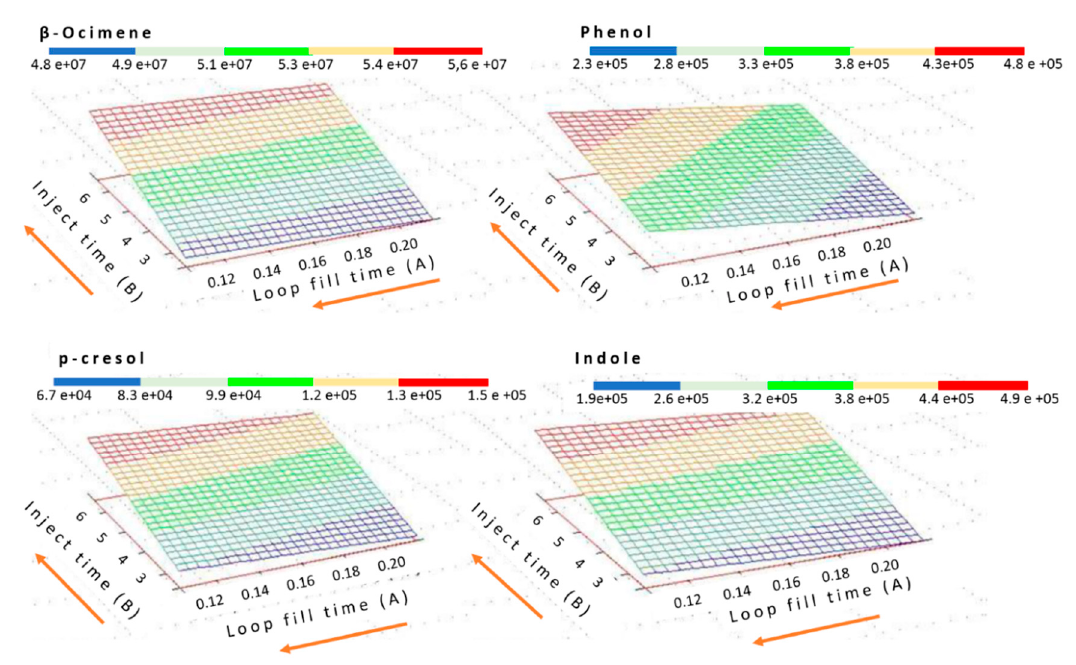
Figure 4. Response surfaces plots using central composite design (CCD), obtained for each bioattractant for injection time and loop fill time optimization of HS-GC/MS.